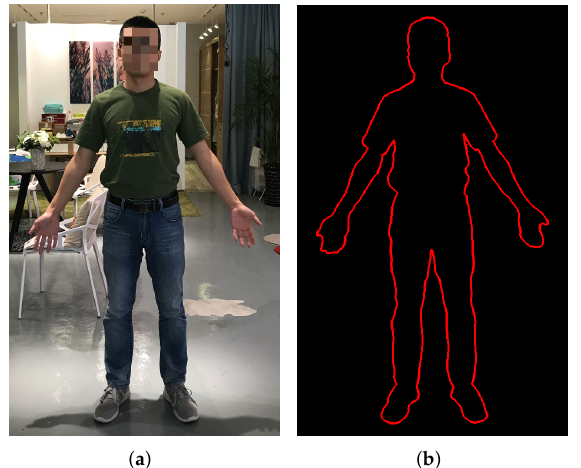
Figure 1. An example of profile in existing segmentation dataset. ( a ) Input image and ( b ) correspond- ing